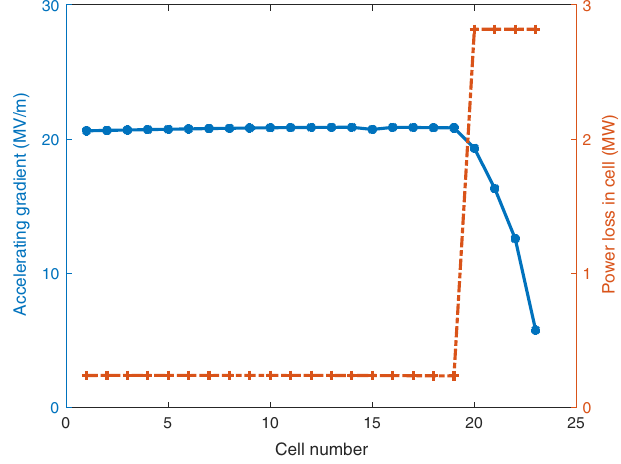
FIG. 4. Accelerating gradient and power loss in each cell of the TW linac when the input power is 16 MW.